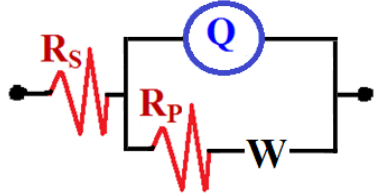
Figure 7. The equivalent circuit model used for best fitting the EIS experiments.